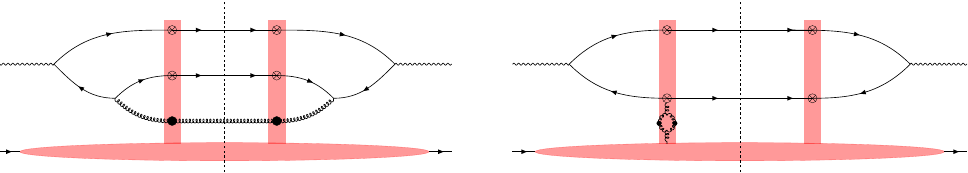
Figure 2 . (Left) Diagram ( R 0 × R 0 ) for a real gluon emission crossing the shockwave both in the 1 1 amplitude and in the complex conjugate amplitude. (Right) Diagram from the one-loop correction to the shock-wave “above the cut” (contributing to the NLO impact factor) times the leading order amplitude. See discussion in the